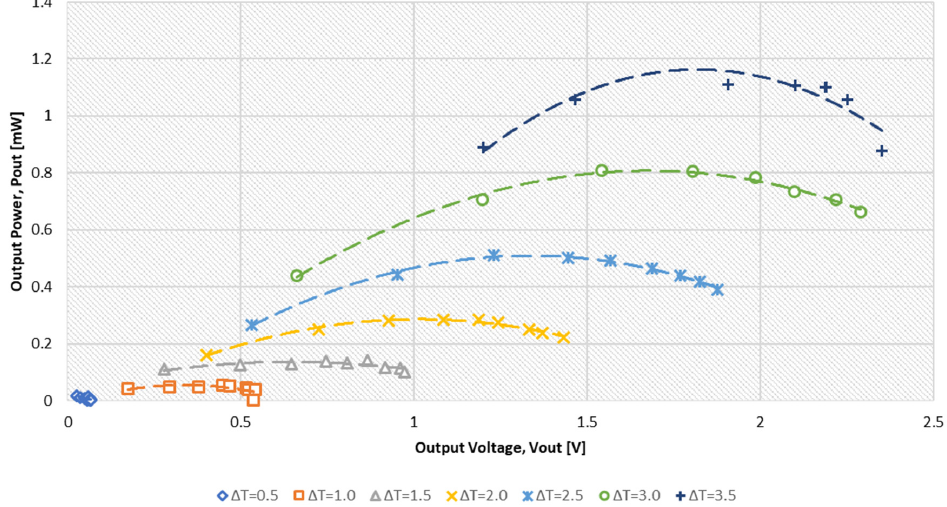
Figure 7. Thermal EHC Output Power–Output Voltage curve at 2.3 V.